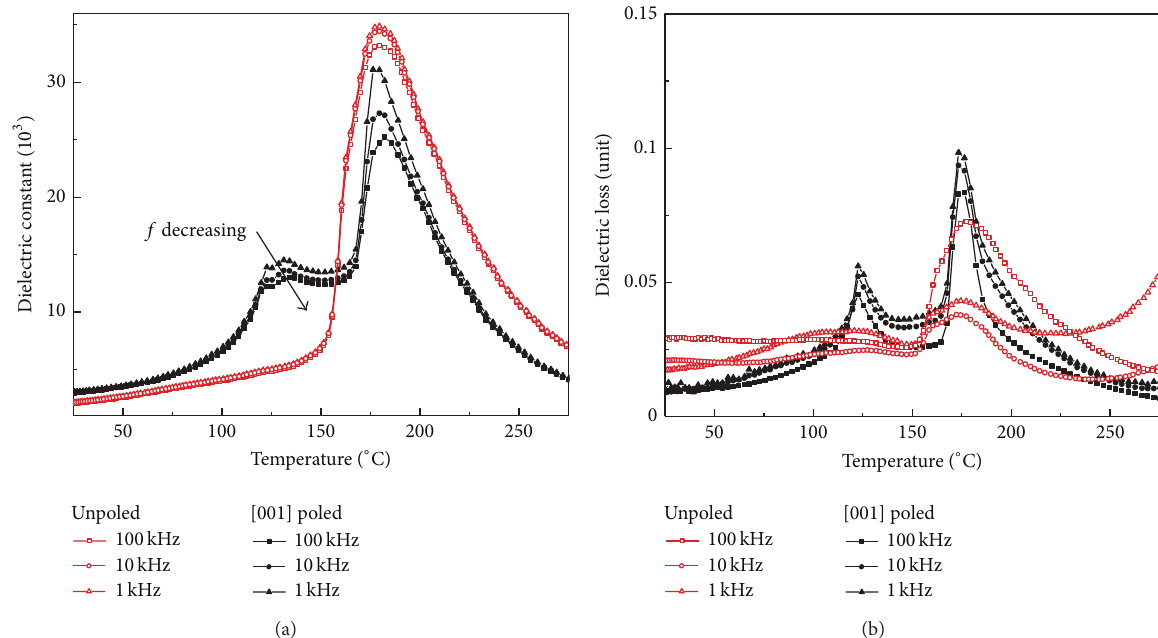
Figure 1: Temperature dependent dielectric constant (a) and loss (b) at several frequency points for the unpoled and [001] -poled 0.29PIN- 0.44PMN-0.27PT single